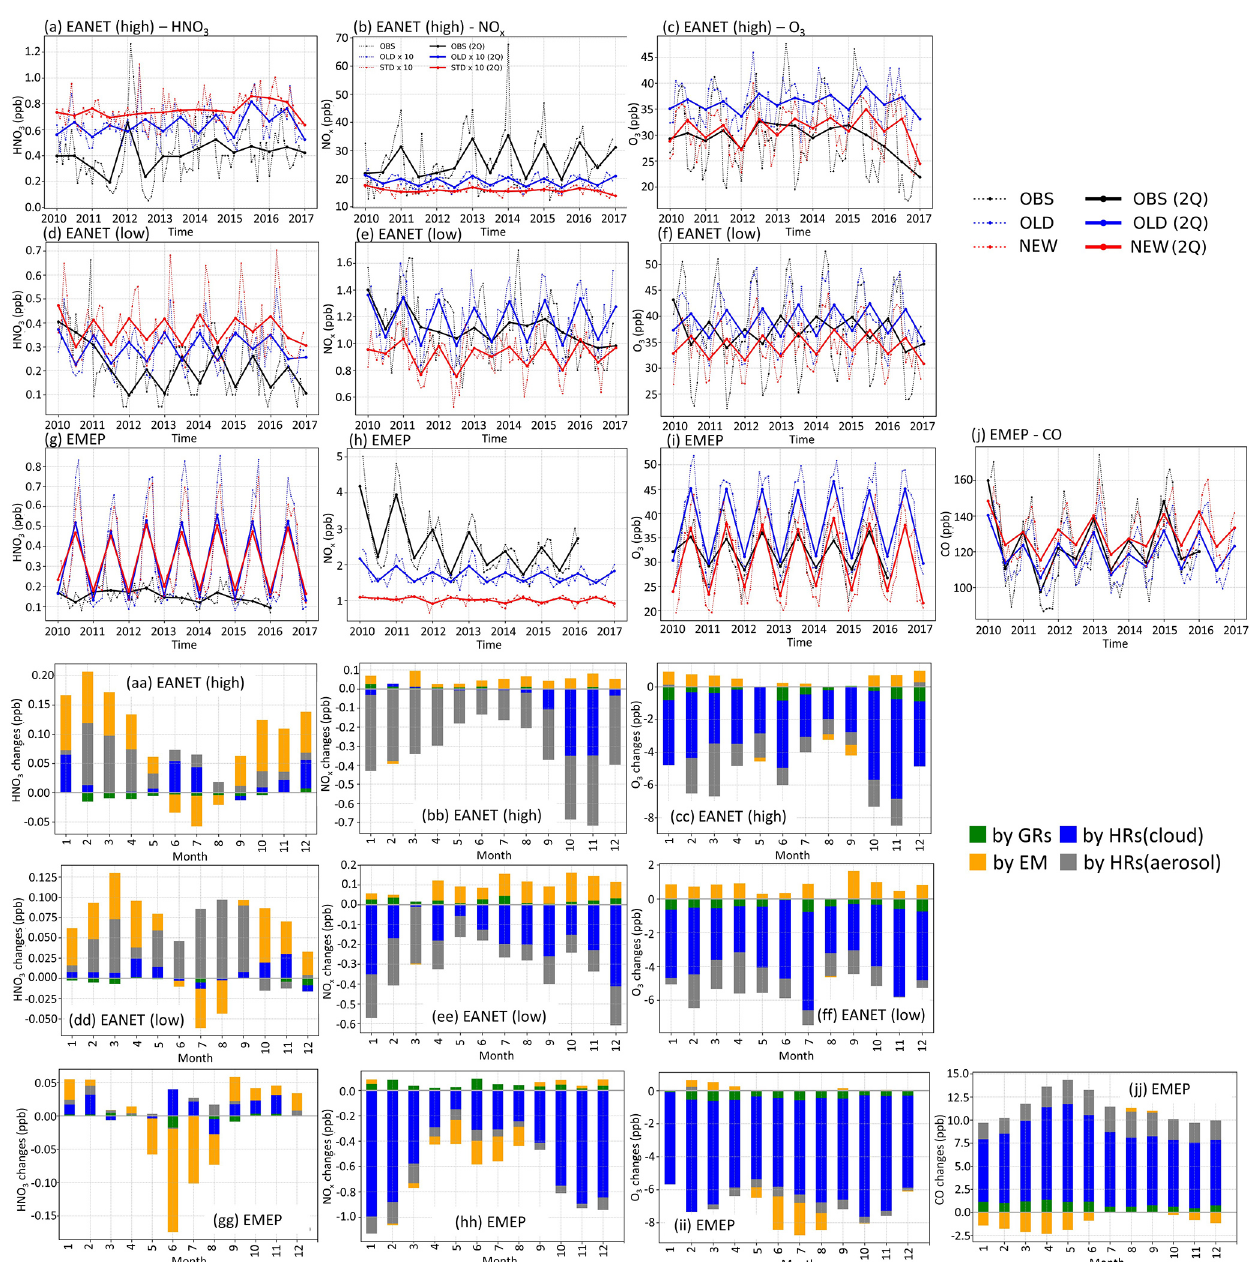
Figure 10. Concentrations and changes by HONO inclusion for EANET and EMEP stations. (a–j) Observed and simulated concentrations during 2010–2016. Black lines: observation; red: STD case; blue: OLD case. In panel (b) , concentrations in STD and OLD are increased 10 times for better visualization (red and blue lines). For each group of stations, dotted lines are all the station medians from each station’s monthly-mean values. Thick solid lines represent two-quarters averaged from dotted lines. (aa–jj) Calculated monthly-mean changes by HONO chemistry. Green bars: monthly changes by GRs; blue: monthly changes by HRs on clouds; grey: monthly changes by HRs on aerosols; orange: monthly changes by EM. Stations are grouped as high-NO x EANET (first and fourth rows), low-NO x EANET (second and fifth rows), and all EMEP stations (third and sixth rows). First column: HNO 3 ; second column: NO x ; third column: O 3 ; fourth column: